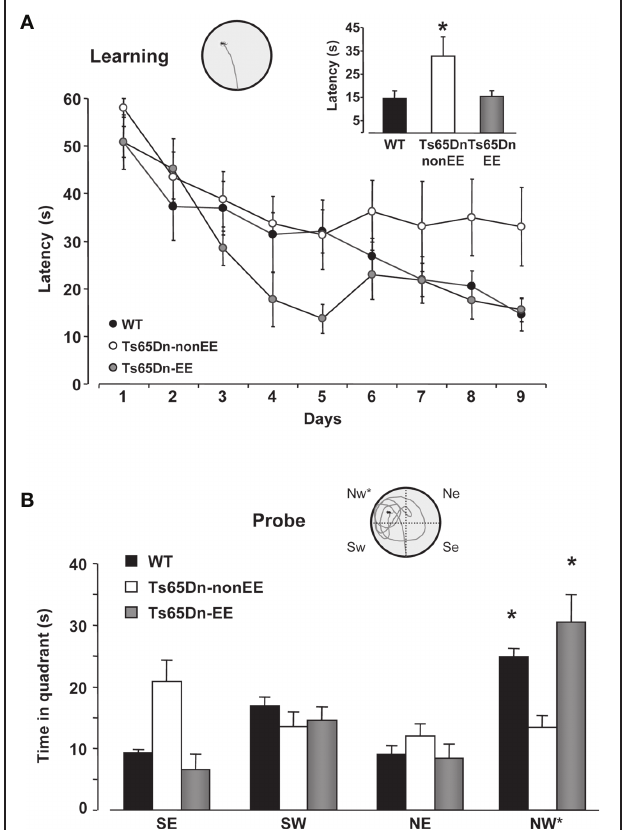
FIGURE 1 | Environmental enrichment promotes spatial learning in Ts65Dn mice. (A) Learning curves for WT (black) and Ts65Dn mice maintained in standard (Ts65Dn-non-EE, white) or enriched (Ts65Dn-EE, gray) environmental conditions. The histogram shows latency to locate the submerged platform on the last day of training for the three groups. One-Way ANOVA followed by a multiple comparison procedure (Holm–Sidak method) showed a statistical difference between WT and Ts65Dn-non-EE mice, but not between WT and Ts65Dn-EE mice ( p = 0 . 885). Inset is an example of swimming path during the last day of training for a Ts65Dn-EE mouse. (B) Probe trial. Two-Way RM ANOVA revealed a statically significant interaction between the genotype group and the pool quadrant ( p < 0 . 001). A Holm–Sidak multiple comparison procedure revealed that while Ts65Dn-non-EE did not show any preference for the target (NW) quadrant, both WT and Ts65Dn-EE mice spent significantly more time in the NW quadrant than in the other quadrants. Moreover, the time spent in the target quadrant was shorter in Ts65Dn-non-EE mice than in the other two groups, which instead did not differ between each other ( p = 0 . 1). Inset shows an example of swimming path during the probe session for a Ts65Dn-EE mouse. *Statistical significance. Error bars,